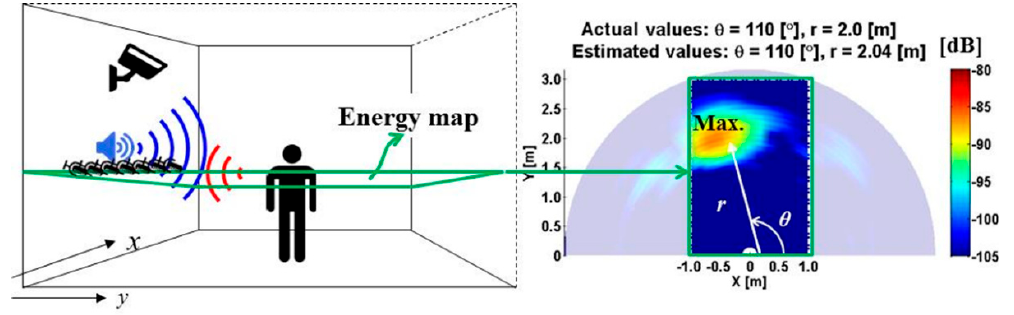
Figure 3. Example of an application of the proposed active localization method to a room.